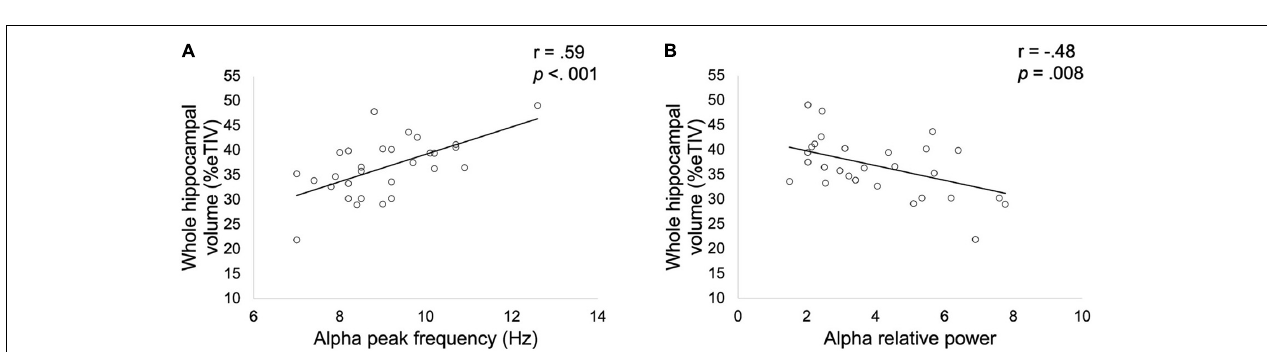
FIGURE 3 | Correlation between whole hippocampal volume expressed as a percentage of total intracranial volume (TIV) and alpha peak frequency (A) or relative alpha power (B) obtained in patients with altered FCSRT performance. Correlation coefficients r and p values (Bonferroni corrected for the two spectral parameters considered) were estimated while controlling for age, gender and years of